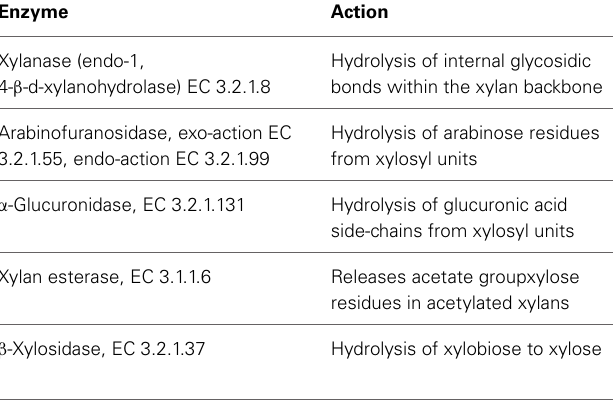
Table 8 | Tannases from marine sources. Recent examples. Microbial source Optimal pH and T ( ◦